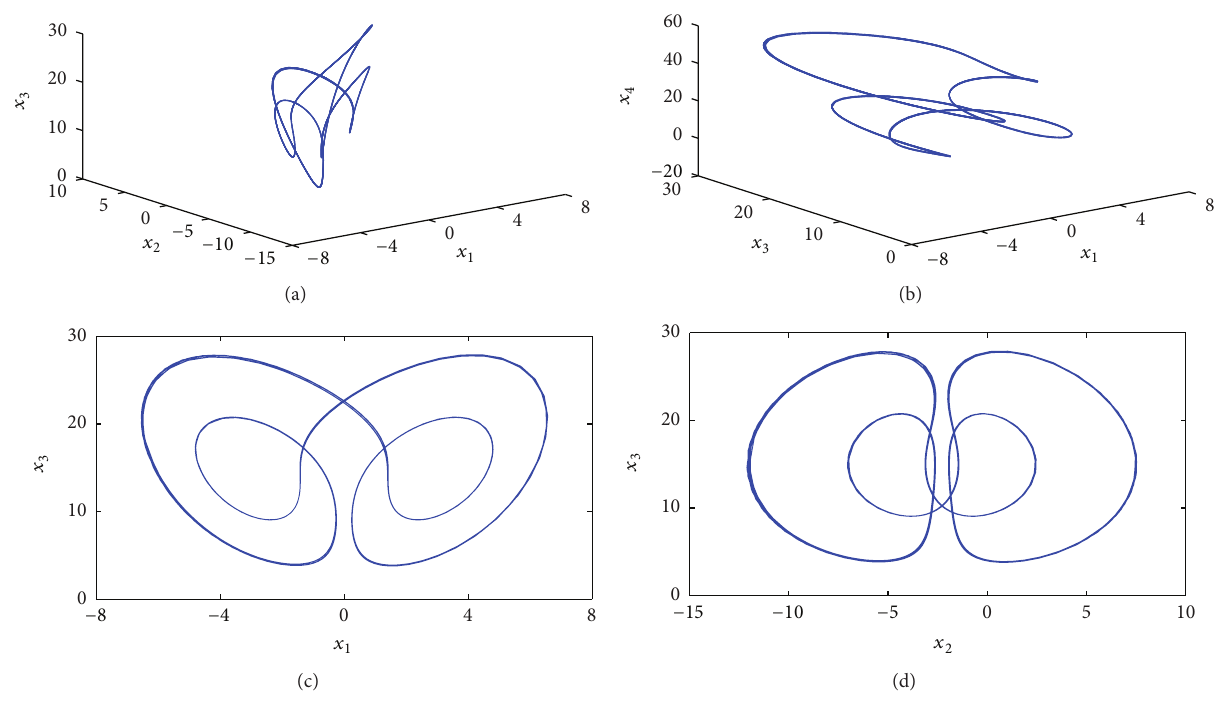
Figure 1: The periodic orbit of fractional-order system (1) for its corresponded integer-order system (𝑞 = 1) .